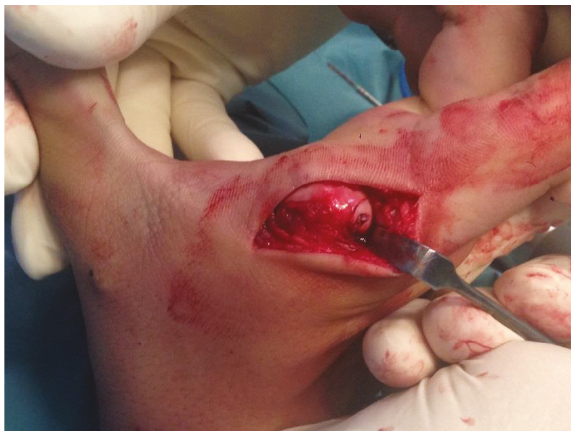
Figure 6: Fixation of the dorsal osteochondral fragment.